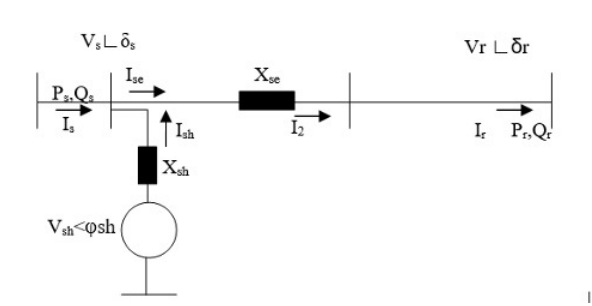
Figure 2. Single Line Diagram of Power Transmission System with STATCOM